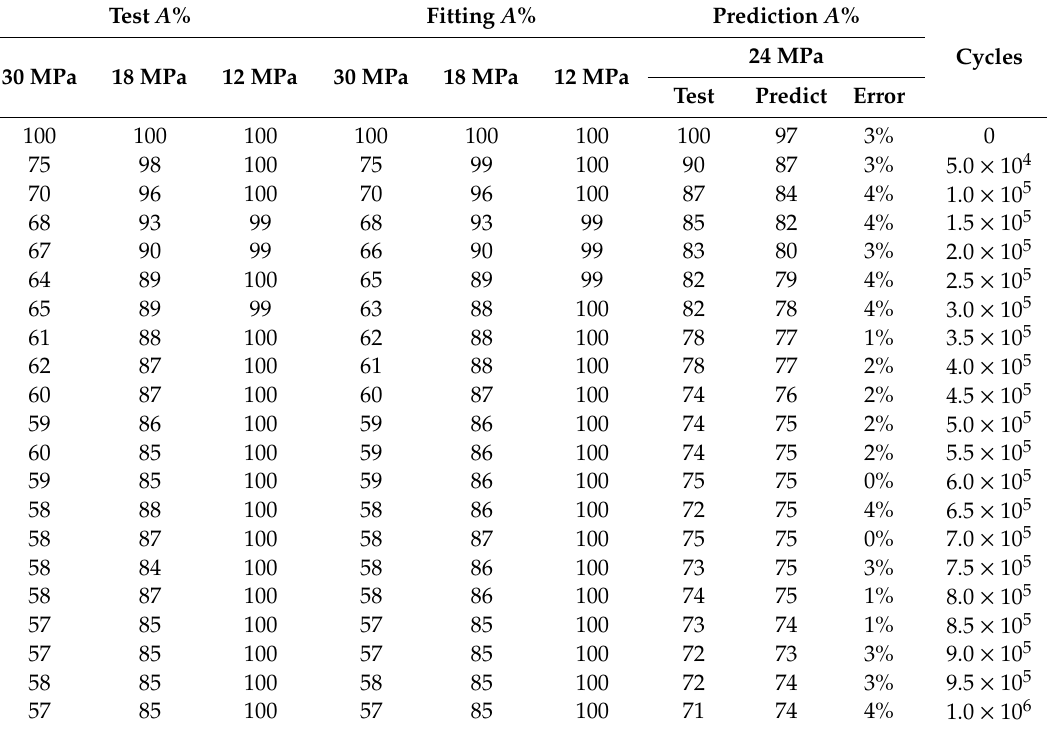
Figure 10. Predicted actuation function degradation curve (red solid line) of the MFC actuator undergoing cyclic load with stress amplitude of 24 MPa. Table 3. Actuation function degradation prediction and